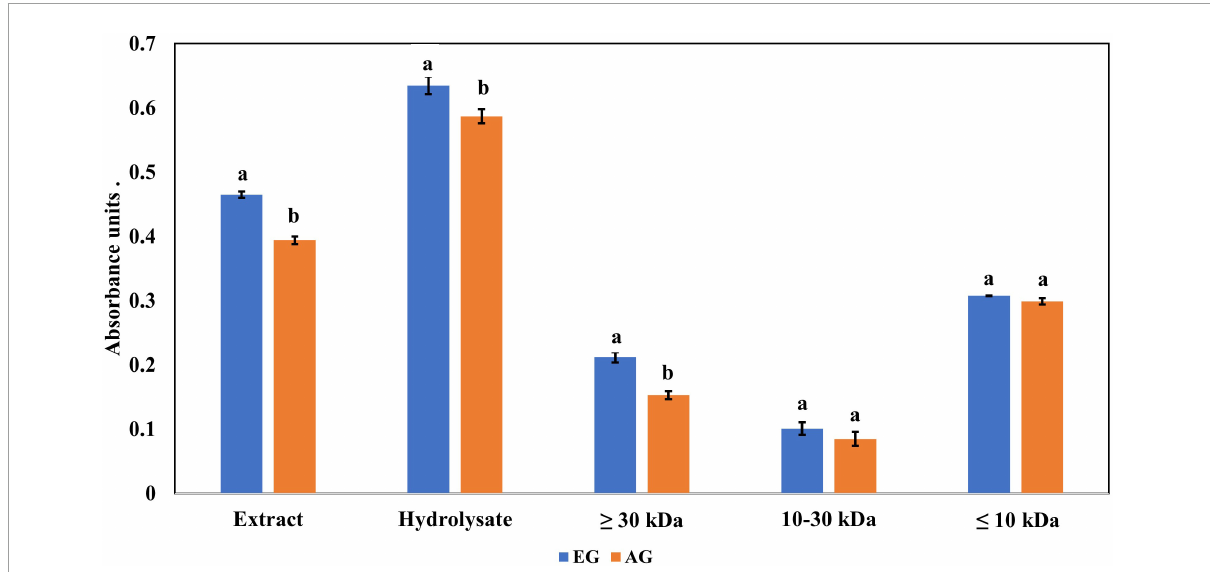
FIGURE4 Ferric reducing antioxidant power of extracts, hydrolysates, and hydrolyzed fractions of early grasshopper (EG) and adult grasshopper (AG). Results are reported in absorbance units at 700 nm. Different letters between bars indicate a significant difference ( p -value <